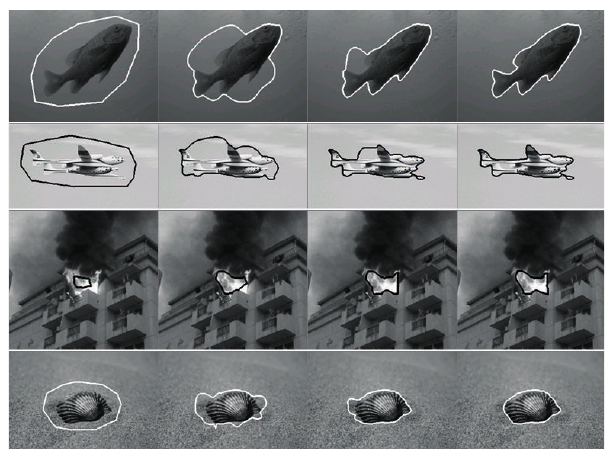
Figure 9: Experiments on real images with complex objects.